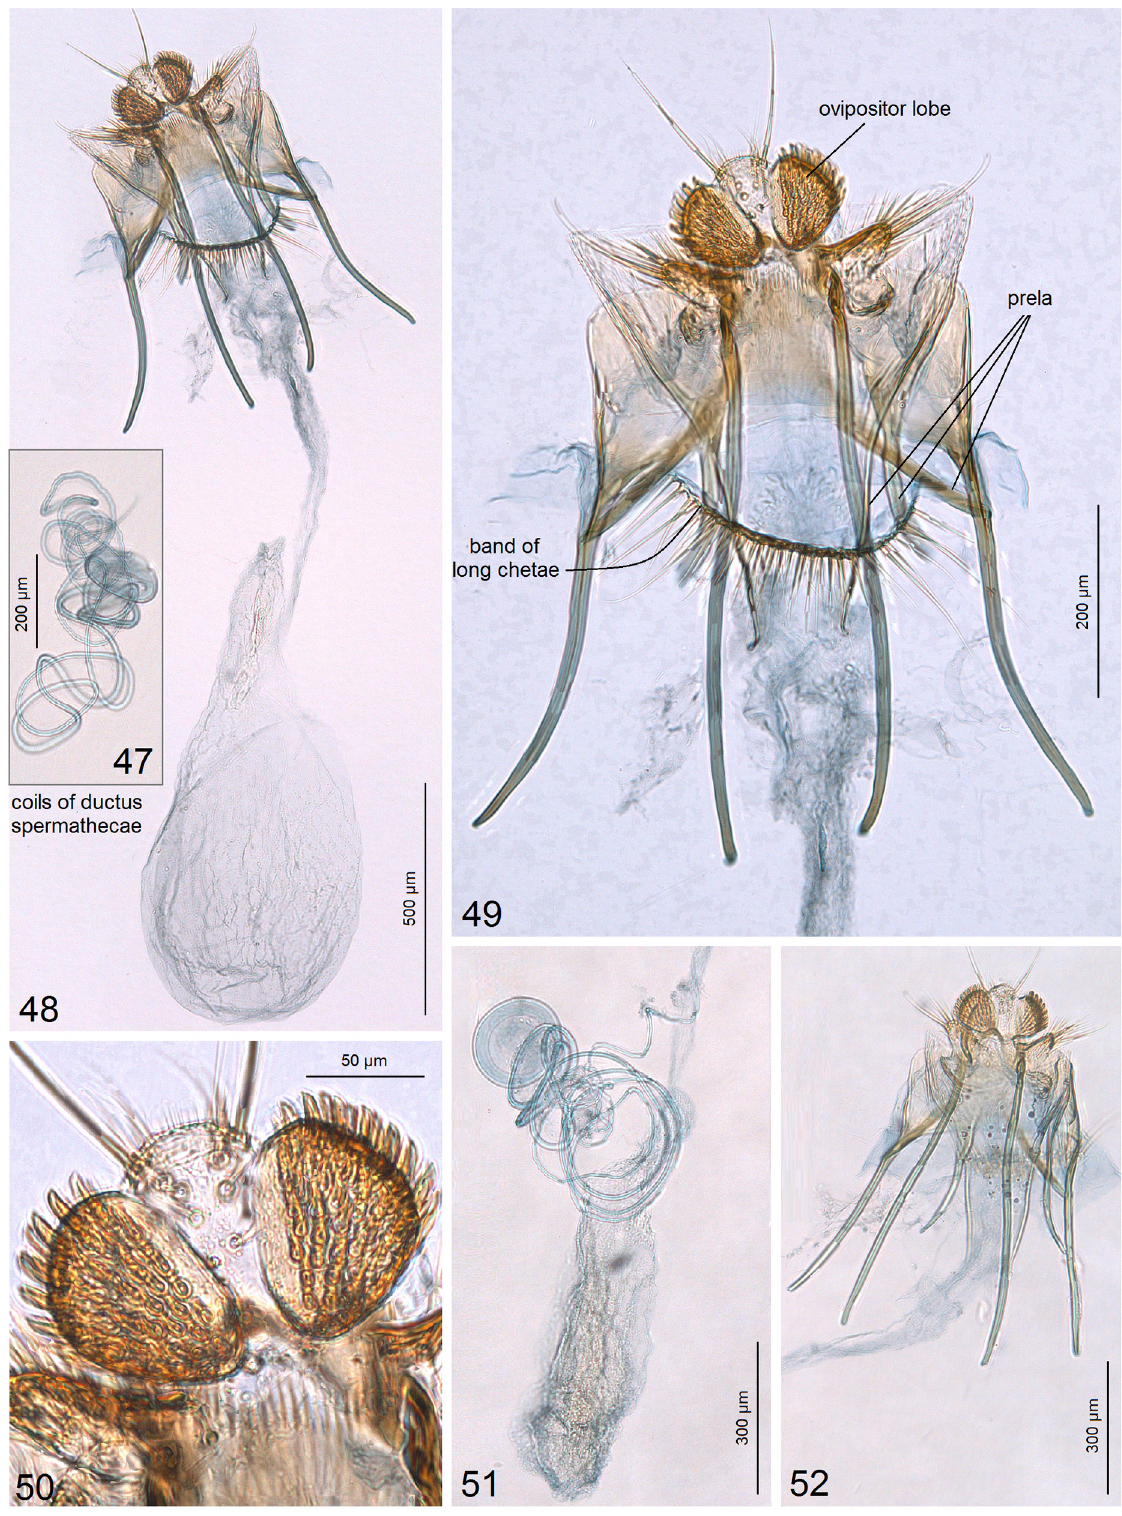
Figs 47–52. Female genitalia of Astrotischeria papilloma Diškus & Stonis sp. nov. 47–50 . General view and details, paratype from Belize (genitalia slide no. 010316186, NHMUK). 51 . Corpus bursae and coils of ductus spermathecae, paratype from Honduras (genitalia slide no. AD916, ZIN). 52 . Same, apophyses and ovipositor